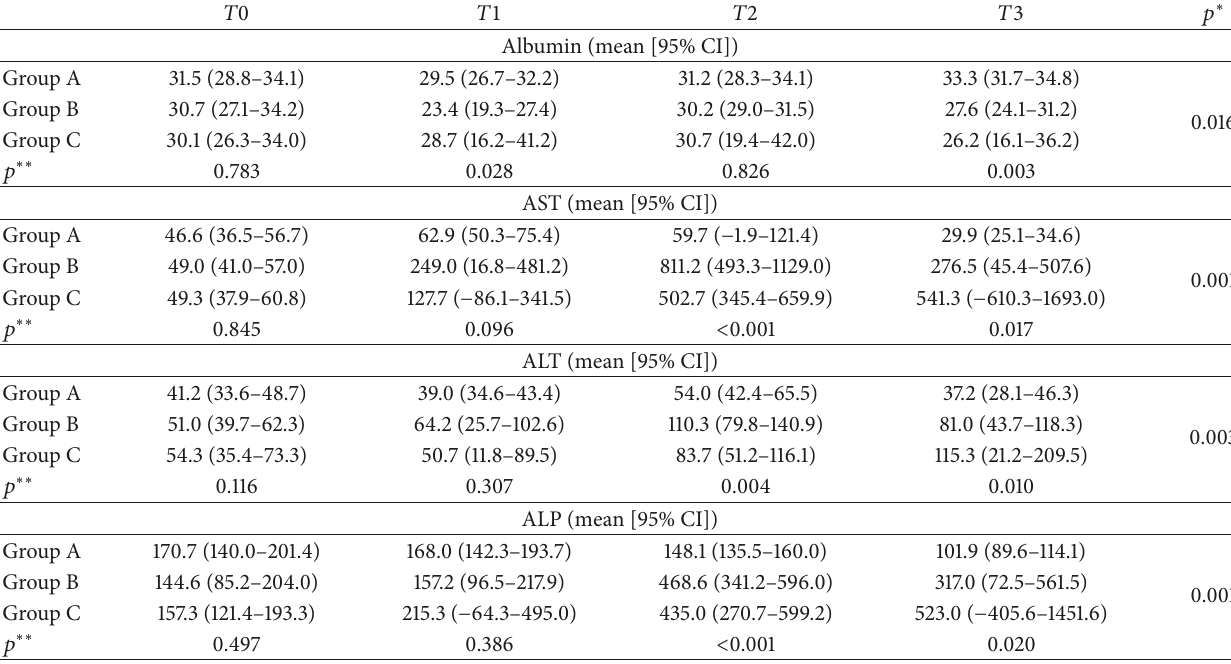
Table 2: Laboratory findings at baseline and during the follow-up